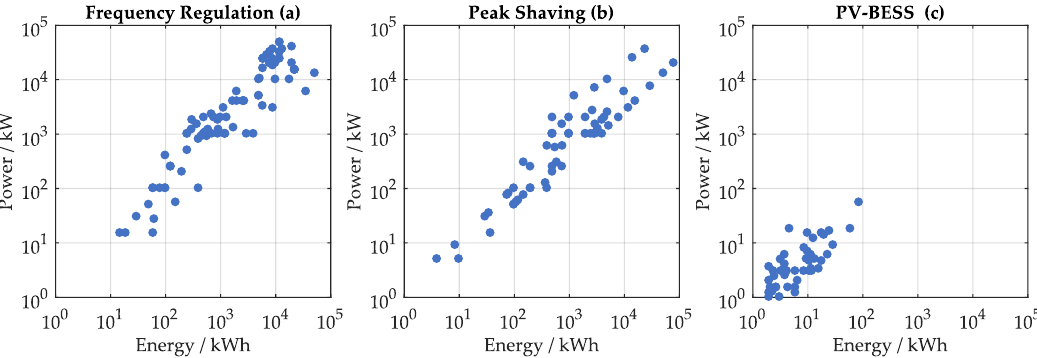
Figure 8. Energy to power ratio analysis for selected real-world projects grouped by storage application: ( a ) Frequency regulation, data from [86]; ( b ) Peak shaving, data from [86]; ( c ) Photovoltaic residential battery storage system, data from